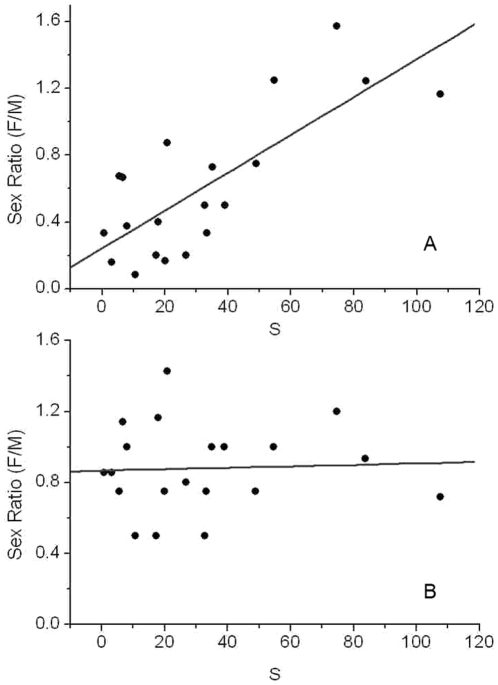
Correlation of patch connectivity index S and sex ratio of individuals (A) younger and (B) older than 50 years in 20 populations of P. chinensis on the studied islands, The Pearson correlation coefficient A: r = 0.77, P<0.0001; B: r = 0.044, P = 0.843.